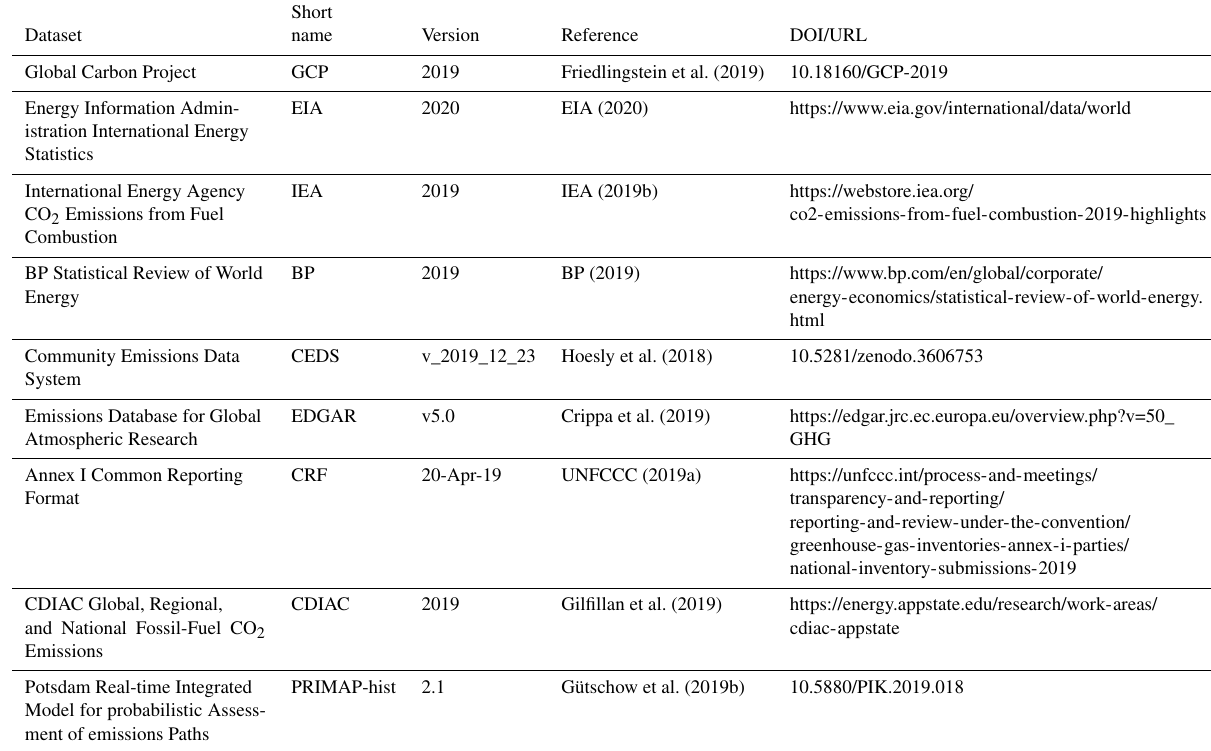
Table 1. Summary of datasets included in this